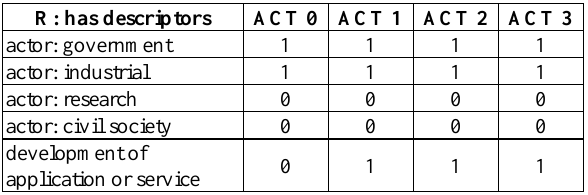
Table 4. Part of the matrix used for Paris city